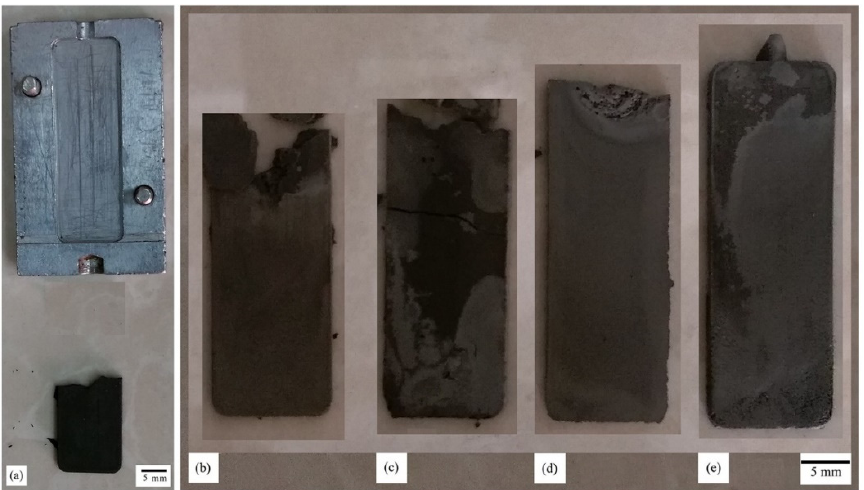
Figure 5. Injection molded parts: ( a ) 60 vol.% powder loading at the feedstock temperature of 165 °C; ( b ) 53 vol.% powder loading at the feedstock temperature of 150 °C; ( c ) 53 vol.% powder loading at the feedstock temperature of 155 °C; ( d ) 53 vol.% powder loading at feedstock temperature of 160 °C; ( e ) 53 vol.% powder loading at feedstock temperature of 165 °C. Reproduced with permission from reference [74], copyright © 2020, Elsevier B.V.